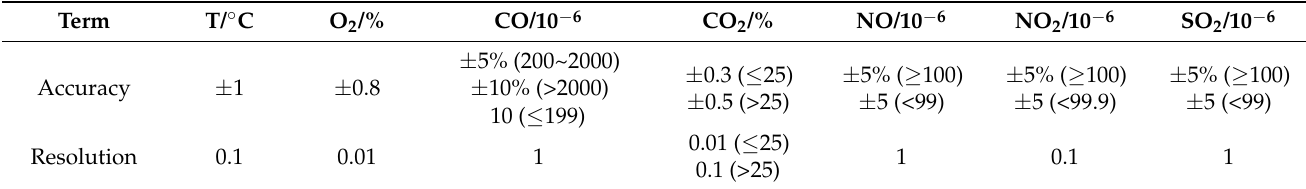
Table 5. Testo 350 gas